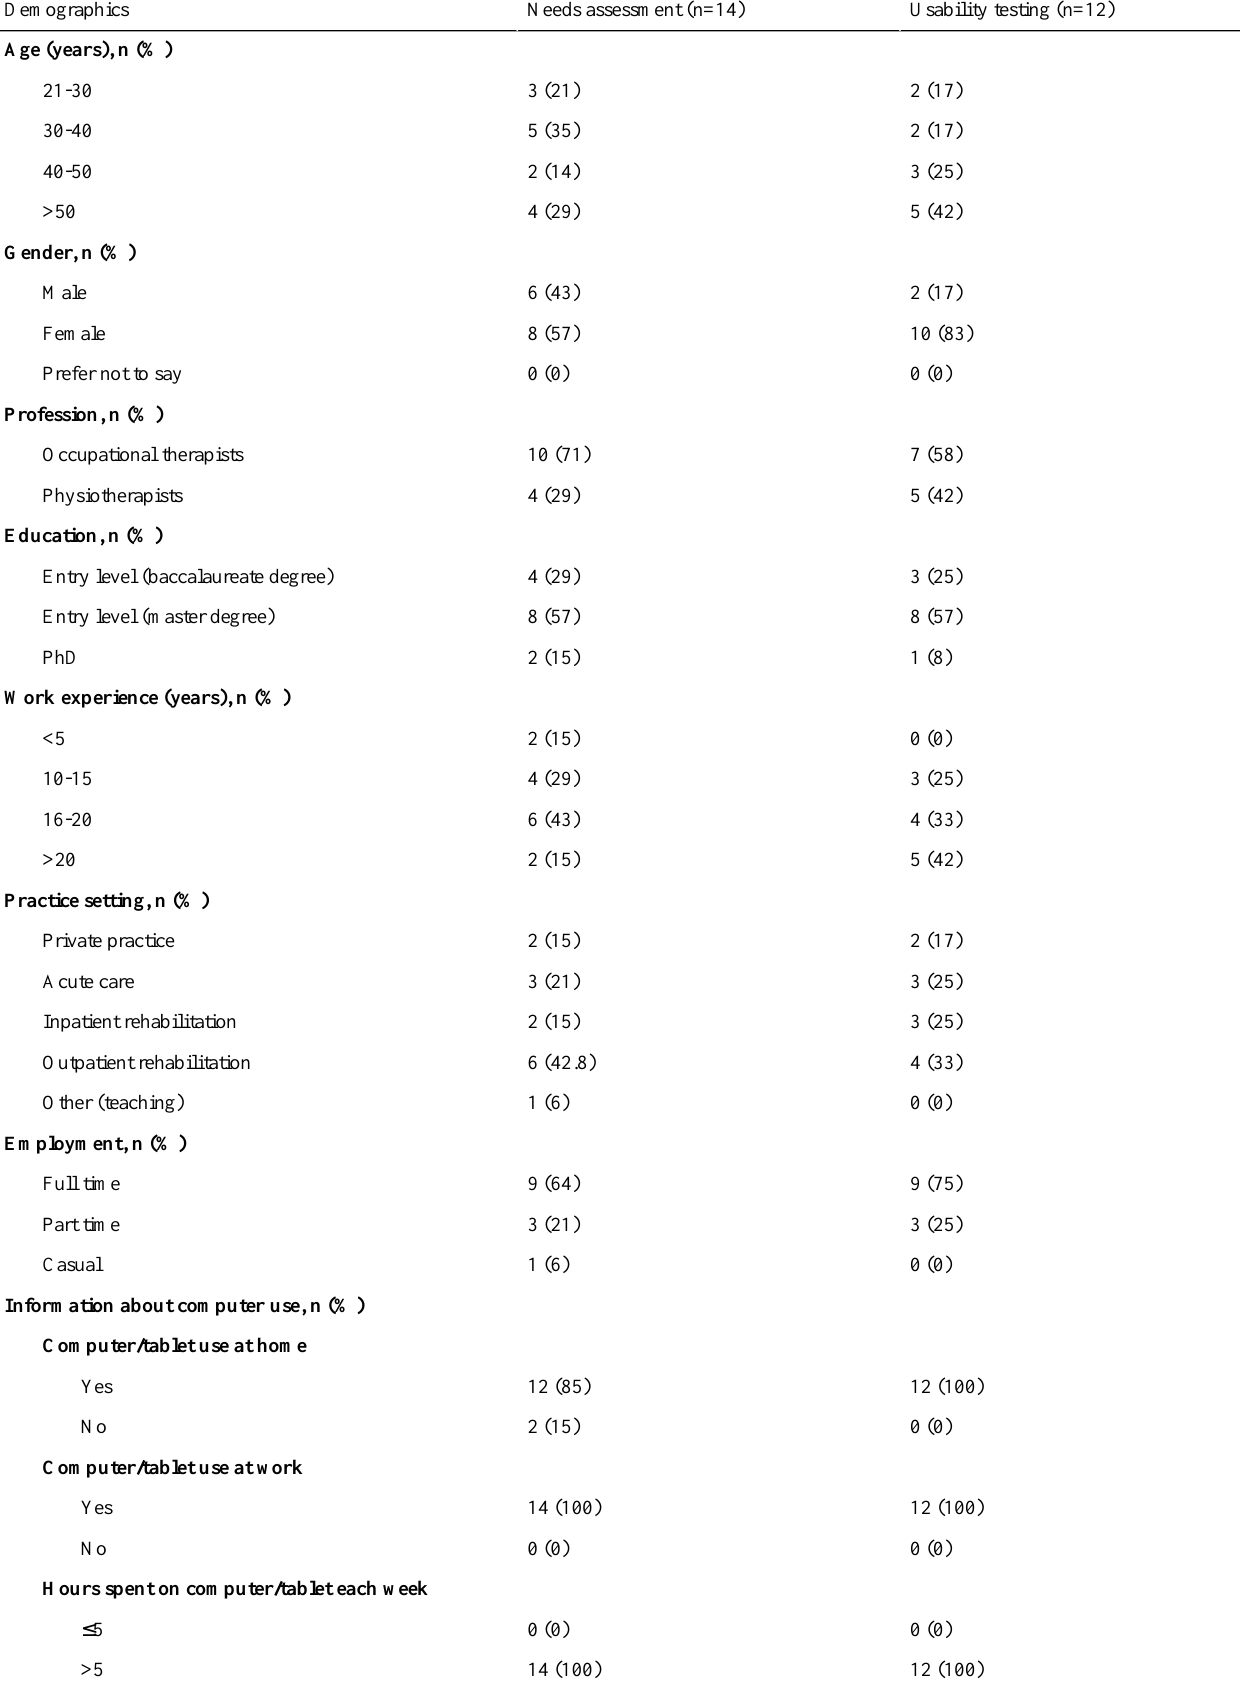
Table 2. Demographic and computer and internet use characteristics of therapists participating in needs assessment/analysis and usability testing of the study